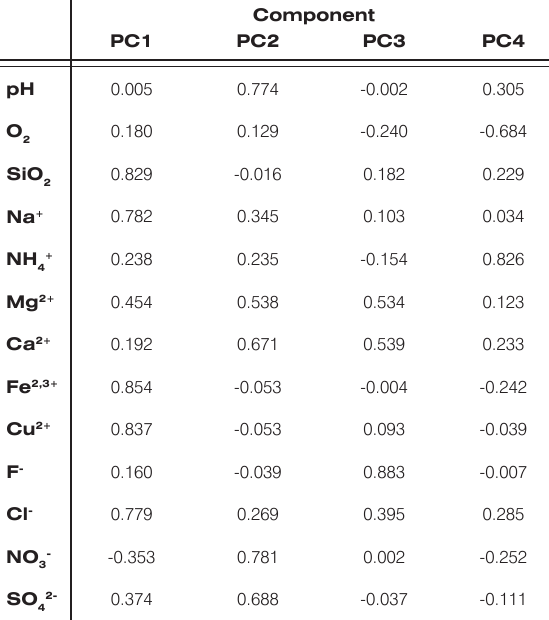
Table 7. Varimax rotated factor loadings of the data for the elements in power plant